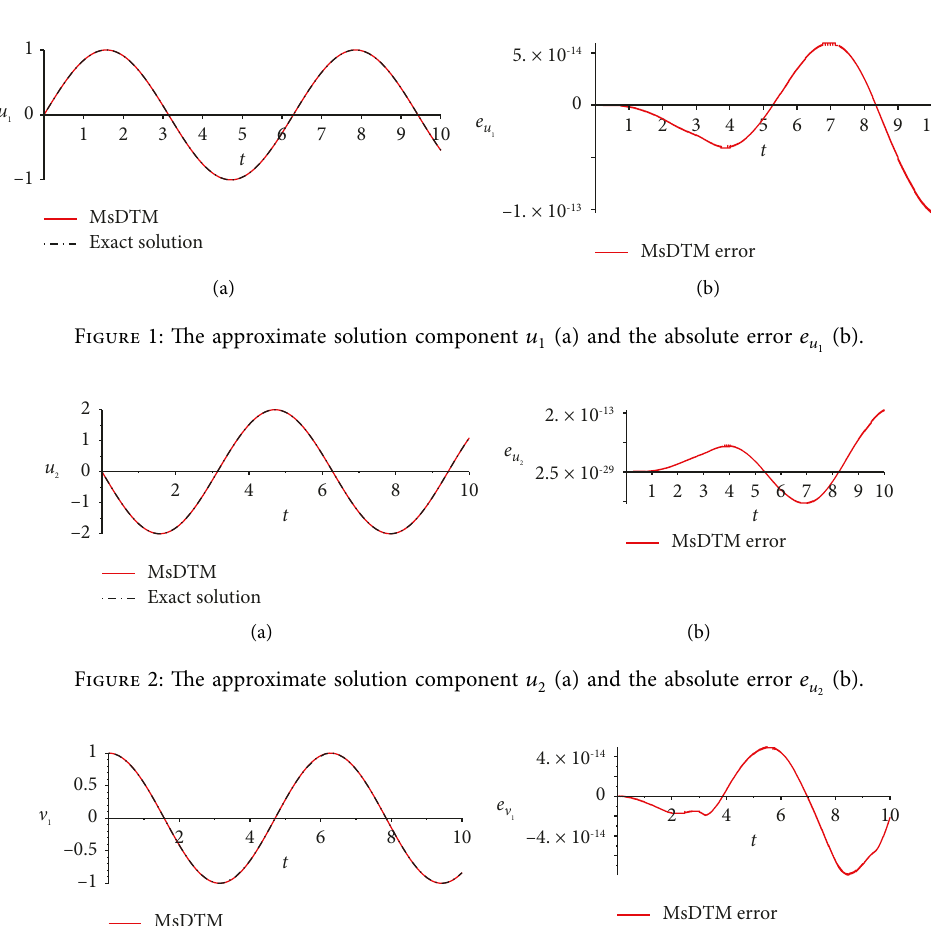
(a) and the absolute error e v 1